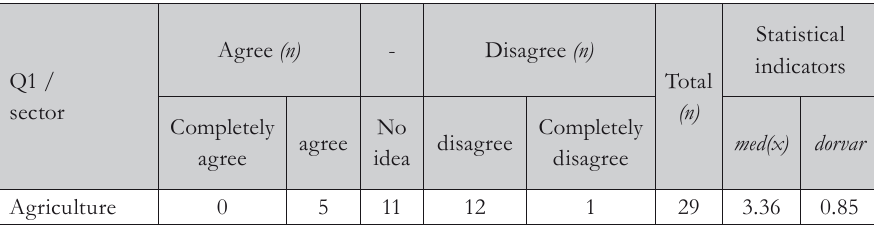
Tab. 1 – Pivot table for Q1a absolute frequency and Statistical characteristics. Source: authors